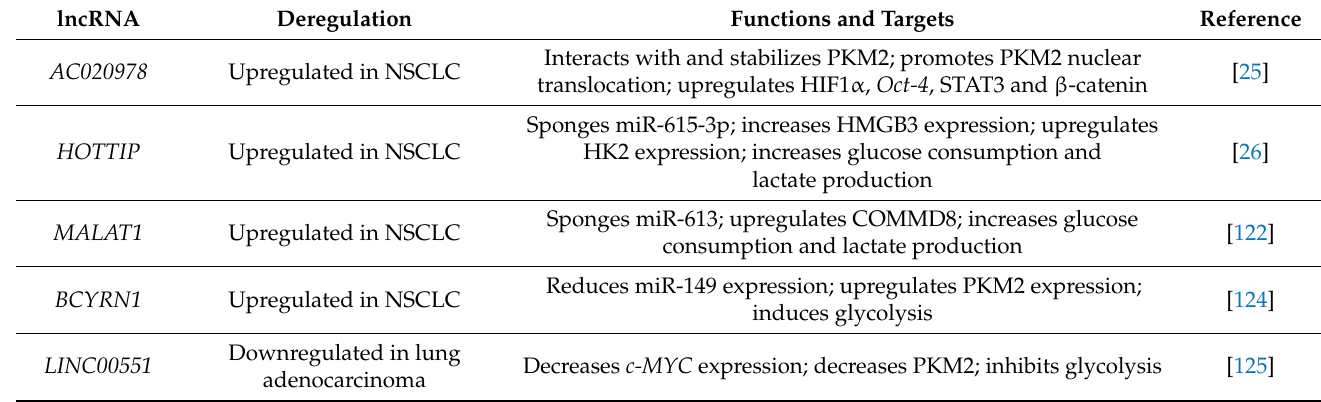
Table 8. Examples of lncRNAs implicated in glucose metabolism alteration in lung